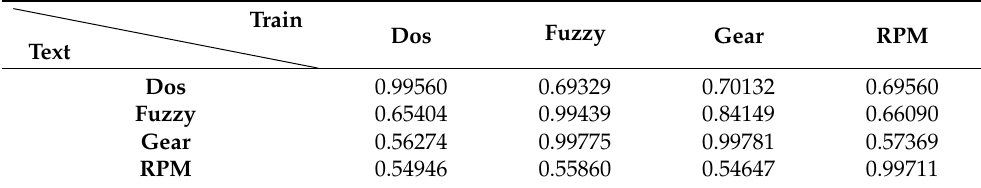
Figure 12. The test time for one sample and the number of parameters in the model, for each method. The vertical axis on the left represents the number of parameters (connections) in the model, while on the right it represents the test time in microseconds. The horizontal axis represents the coding method. Table 6. Cross-validation accuracy of the